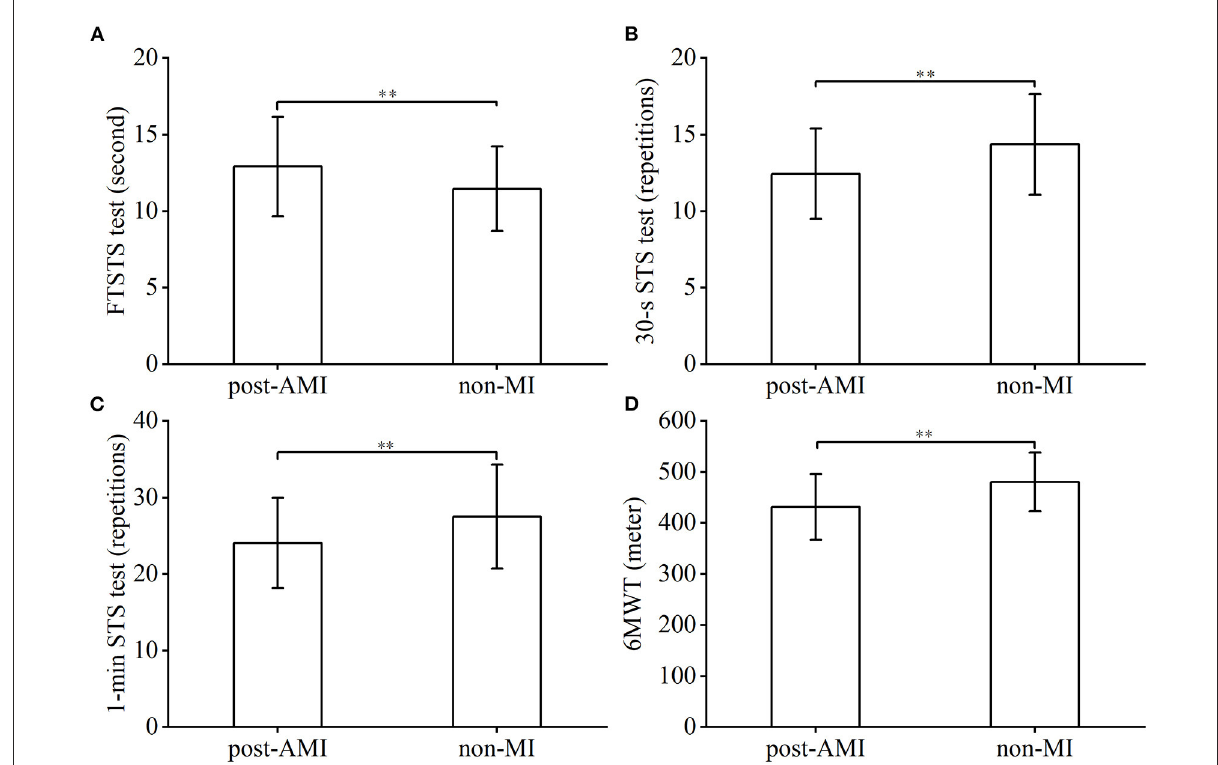
FIGURE2 Intergroup comparison of STS tests and 6MWT performance. FTSTS test: five times sit-to-stand test, 30-s STS test: 30-sec sit-to-stand test, 1-min STS test: 1-min sit-to-stand test, 6MWT: six-min walk test, post-AMI: post-acute myocardial infarction. ** p < 0.01.